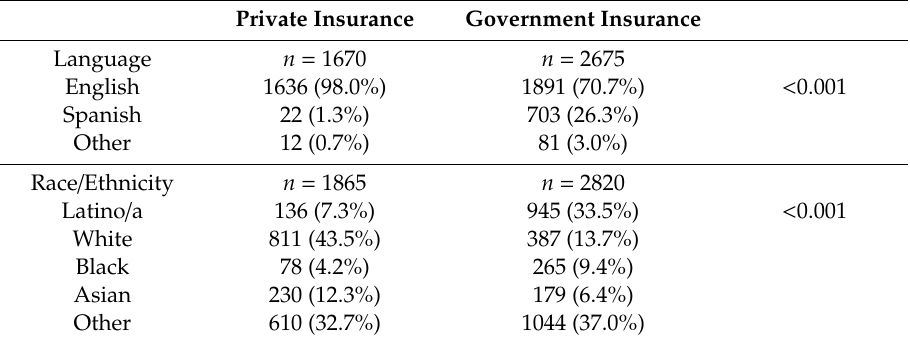
Table 3. Private versus government insurance type versus primary language and race /